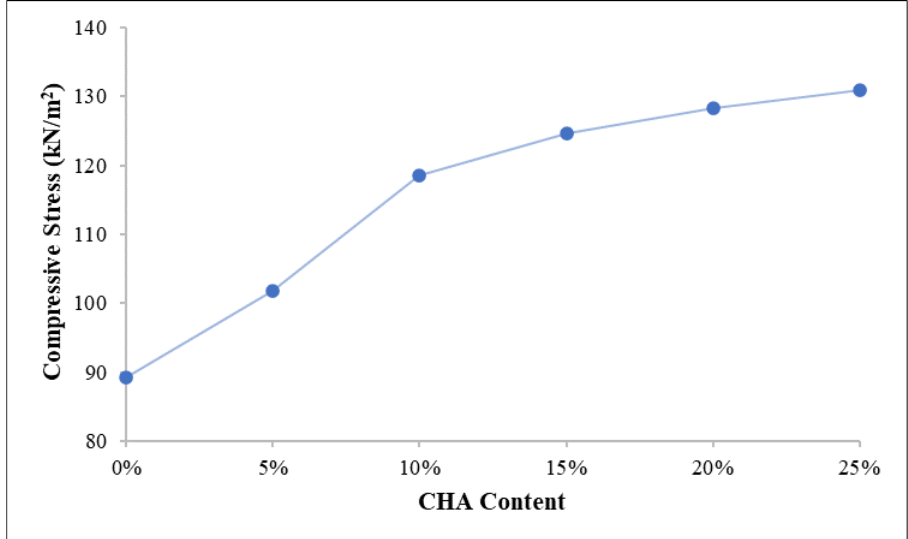
Figure 9. UCS of clay – CHA